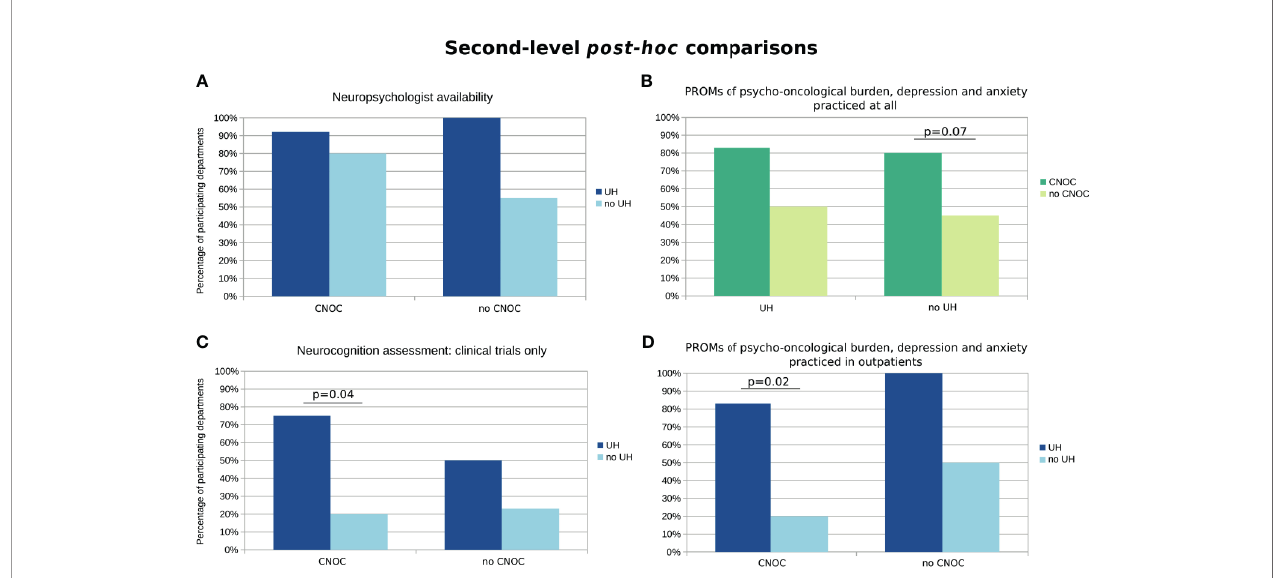
FIGURE 1 | Second-level post-hoc comparisons of available health care structures and assessment practices in fl uenced by quality assurance and institutional factors (i.e., either CNOC or UH af fi liation as grouping factors). The y-axis represents the percentages of departments with (A) availability of the respective health care structures or (B – D) practice regarding the speci fi c assessments. The selection of charts is based on statistically relevant group differences, at least on the level of a statistical trend (p < 0.1) according to the Cochrane Mantel-Haenszel test (cf. colored fi elds in Tables 2 and 3 ). Exact p-values according to post-hoc Fisher ’ s Exact tests (FDR-corrected) are provided if p < 0.1.